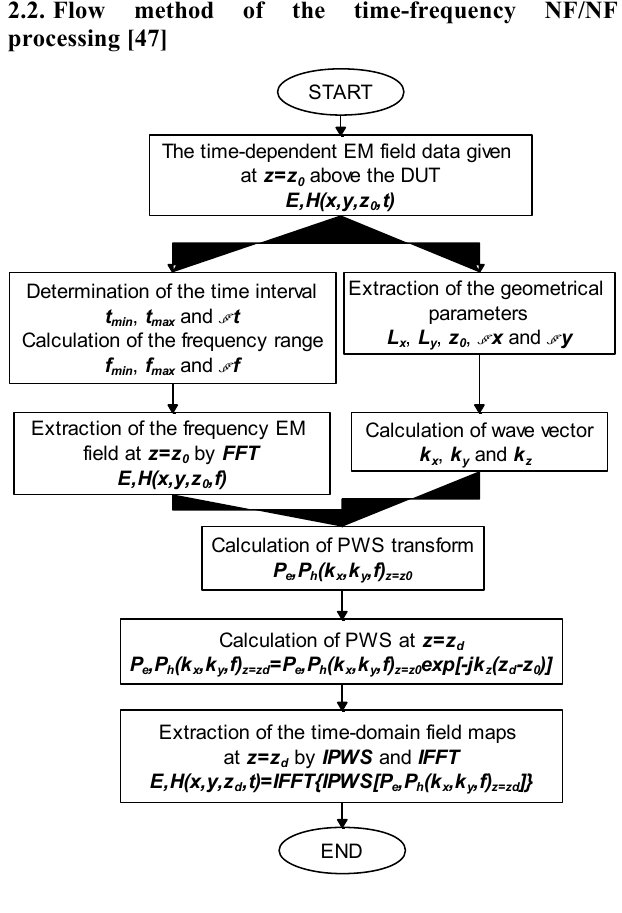
Figure 1: Different steps for extracting the EM field at different heights [47]. Figure 2: Routine process of the NF/NF transform in the time-domain